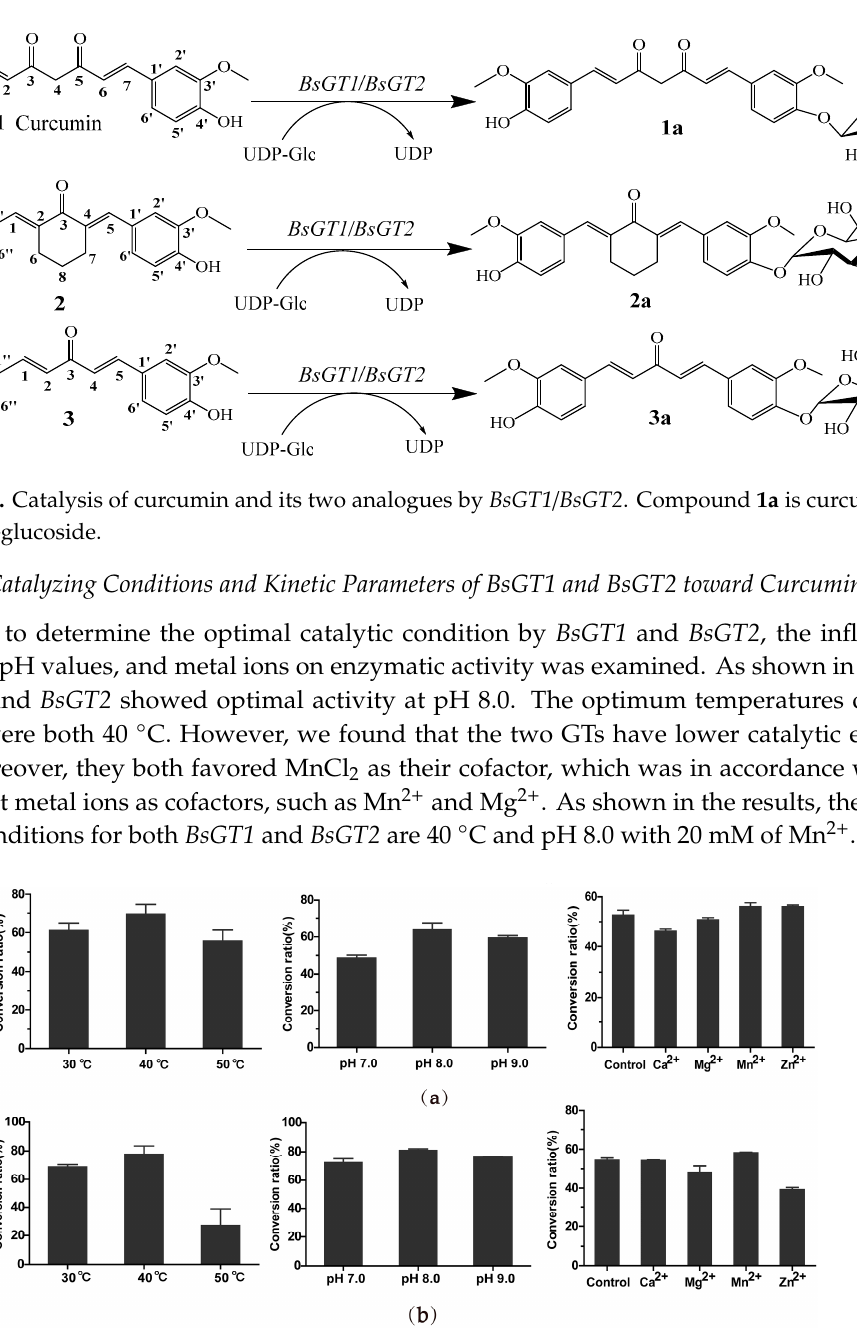
Figure 4. Effects of temperature, pH, and metal ions on BsGT1 (a) and BsGT2 (b) activity in the biosynthesis of curcumin monoglucoside. The mean (n = 2) is shown, and the error bars represent standard deviations.